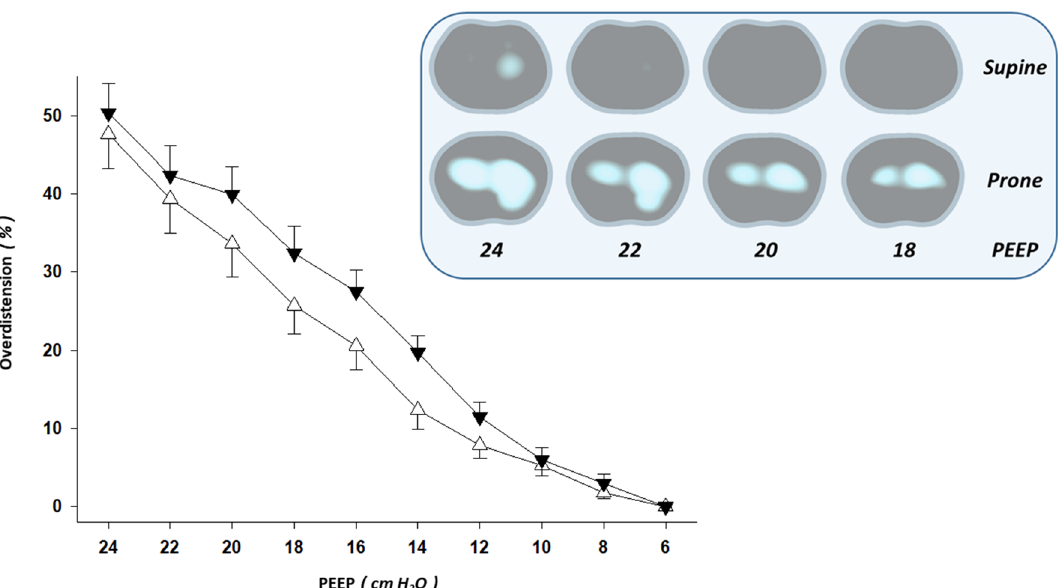
Figure 1. Lung overdistension by electrical impedance tomography in supine vs. prone body position. Line graphs of the electrical impedance tomography (EIT)-based estimations of lung overdistension from forty- two decremental positive end-expiratory pressure (PEEP) titrations—supine vs. prone body position—are shown (mean ± SEM). Some illustrative EIT images of overdistension from one mechanically ventilated patient with coronavirus disease (COVID-19)-induced acute respiratory distress syndrome (ARDS) are also shown: overdistended pixels in white. Note that prone body position increased lung overdistension in comparison with the supine one. Triangle up (white): supine body position. Triangle down (black): prone body position. X axis: decremental PEEP levels of the EIT-PEEP titrations. Y axis: percent of overdistended lung units out of the total lung imaged by